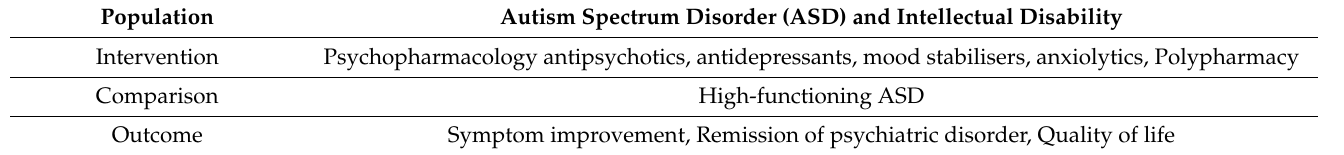
Table 1. PICO Search